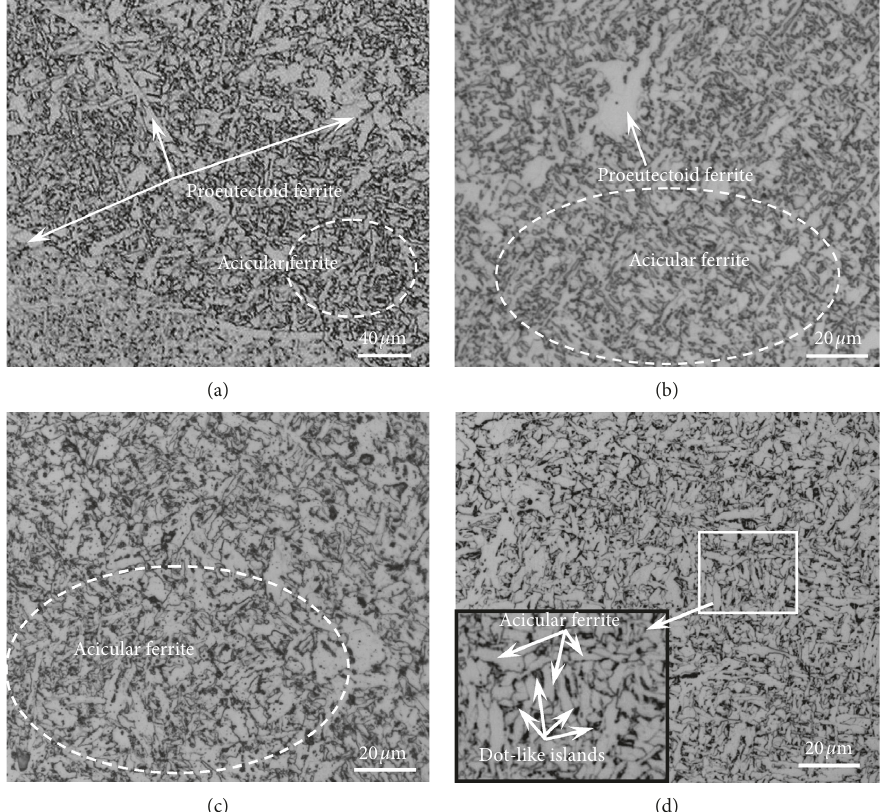
Figure 2: Optical microstructures of the weld metal and after reheating at 990 ° C: (a) Steel A as-weld; (b) Steel A reheating; (c) Steel B reheating; (d) Steel C